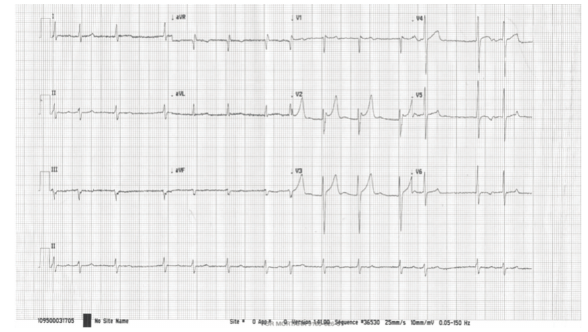
Figure 4: QTc was normalized to 390 ms after day 30.